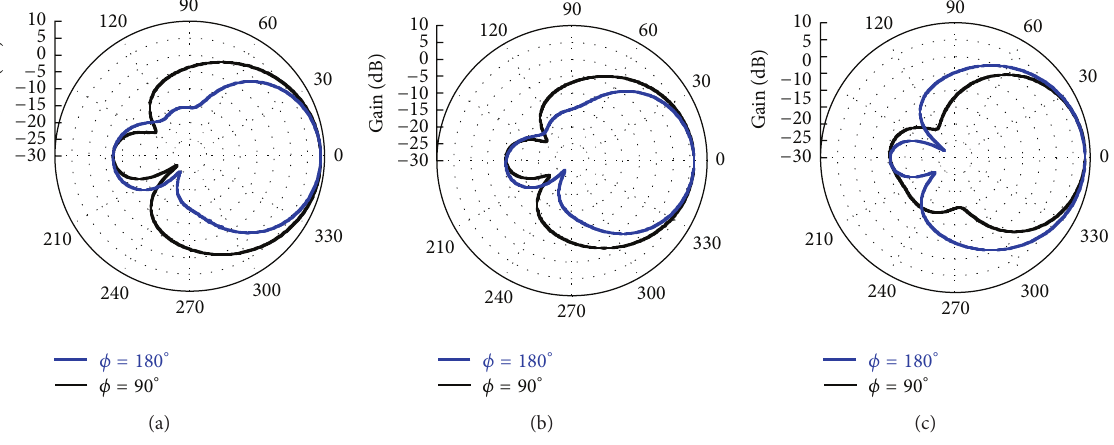
Figure 5: Field patterns. (a) Open, (b) 50 Ω , and (c) short.